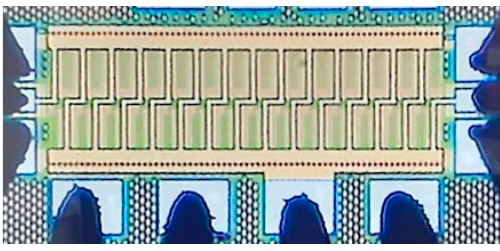
Figure 12. A photograph of the 280 GHz amplifier.